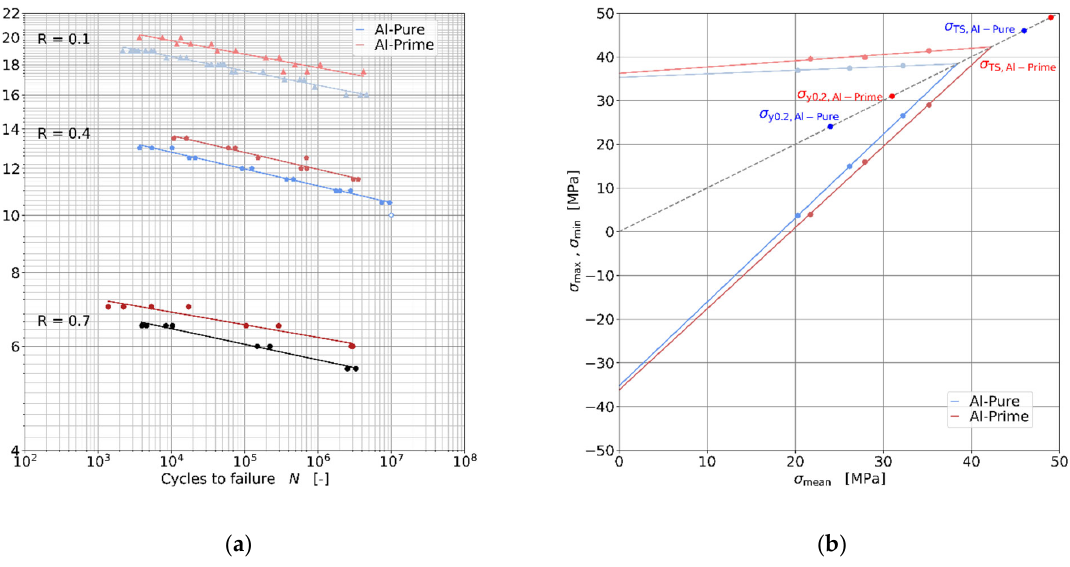
Figure 5. Wöhler diagram of Al ‐ Pure and Al ‐ Prime at R ‐ ratios of 0.1, 0.4 and 0.7 ( a ), Smith diagram of Al ‐ Pure and Al ‐ Prime at 1,000,000 cycles with R ‐ ratios of 0.1, 0.4 and 0.7 ( b ). If the Smith diagrams are calculated at 1,000,000 cycles for Al ‐ Pure and Al ‐ Prime for the three R ‐ ratios 0.1, 0.4 and 0.7 and plotted together, the following diagram results in Figure 5b. A direct comparison of the maximum and minimum stresses shows that these are slightly higher in Al ‐ Prime than in Al ‐ Pure. It is also noticeable that the mean stresses σ mean of Al ‐ Prime are slightly shifted to the right and that this shift increases with increasing R ‐ ratio. This means that the range in which the maximum and minimum stresses of Al ‐ Prime can be varied is slightly larger than in Al ‐ Pure. Due to the different slopes of the maximum and minimum stress lines of both wire types, they meet at different mean stresses σ mean . For Al ‐ Prime, the point intersection of the stress lines is about 42 MPa, which is slightly higher than that of Al ‐ Pure with 38 MPa. The intersection points for Al ‐ Pure and Al ‐ Prime are both significantly above the initial yield stress σ y0.2 ; they are located approximately 60% between initial yield stress σ y0.2 and tensile strength σ TS for Al ‐ Prime and 64% for Al ‐ Pure, respectively. Since all maximum stress values σ max are also significantly above the initial yield stress σ y0.2, a massive plastic deformation can be expected for both wire types with slightly more plastic deformation for Al ‐ Pure. 3.2.3. Influence of Yield Stress and Strength on the Fatigue Behavior For estimating the influence of the initial yield stress σ y0.2 and the tensile strength σ TS on the fatigue behavior the Wöhler and Smith diagrams of both wire types are scaled to the values of the initial yield stress σ y0.2 and the tensile strength σ TS, respectively. The resulting diagrams are shown in Figure 6a,b and Figure 7a,b. A scaling to the initial yield stress σ y0.2 switches the order of the results, meaning that after scaling the values of Al ‐ Pure are above these of Al ‐ Prime. In addition, the curves are further apart than in the unscaled plots in Figure 5a,b. Instead, by a scaling to the tensile strength σ TS the Wöhler and Smith diagrams coincide. This indicates that the fatigue limit is significantly influenced by the strength of the material and that batch ‐ to ‐ batch scatter of the strength, which is usually significantly